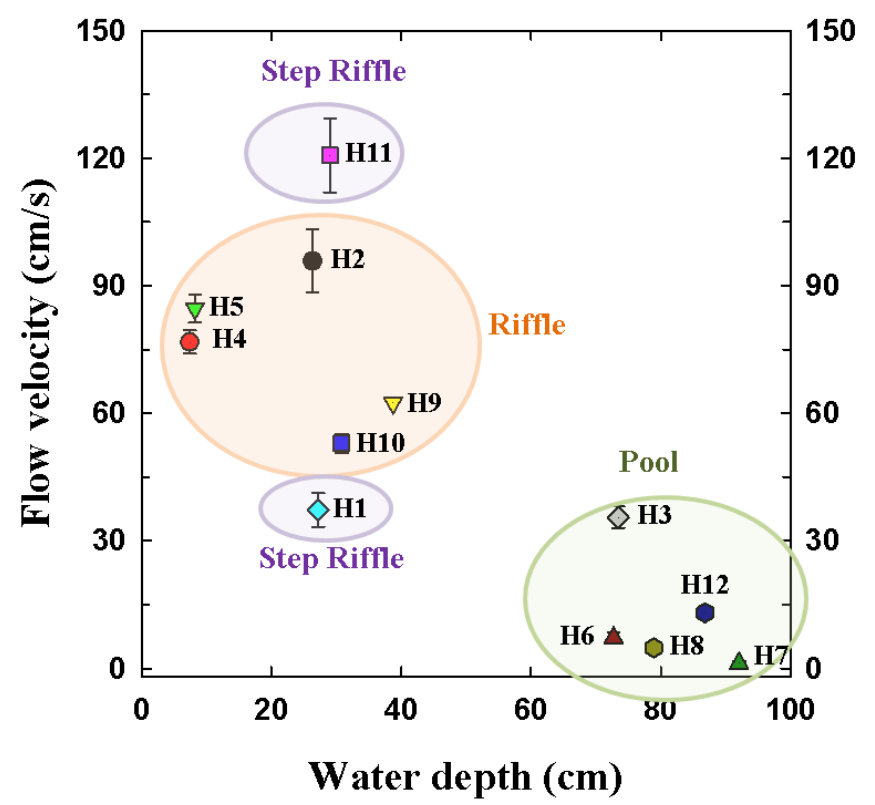
Figure 3. Mean (±S.D.) flow velocity and water depth of different reaches (H1 – H12). Figure 3. Mean ( ± S.D.) flow velocity and water depth of different reaches (H1–H12).